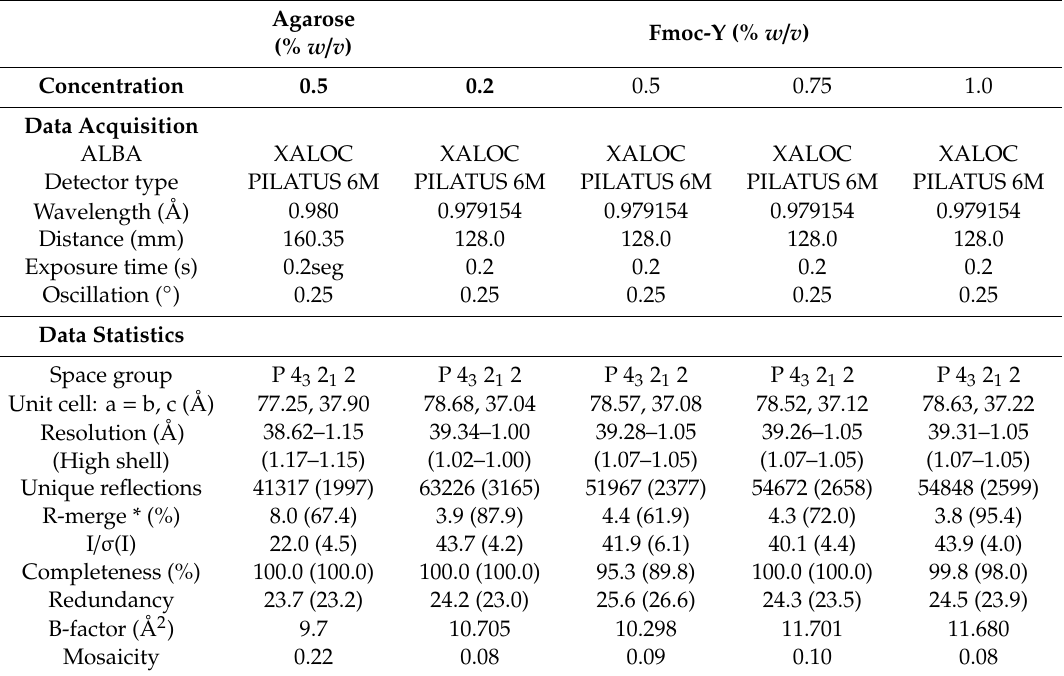
Table 4. Summarized data collection conditions and final statistical values of lysozyme crystals obtained in Fmoc-Tyr-OH (Fmoc-Y) and in agarose hydrogels (data in brackets correspond to high-resolution